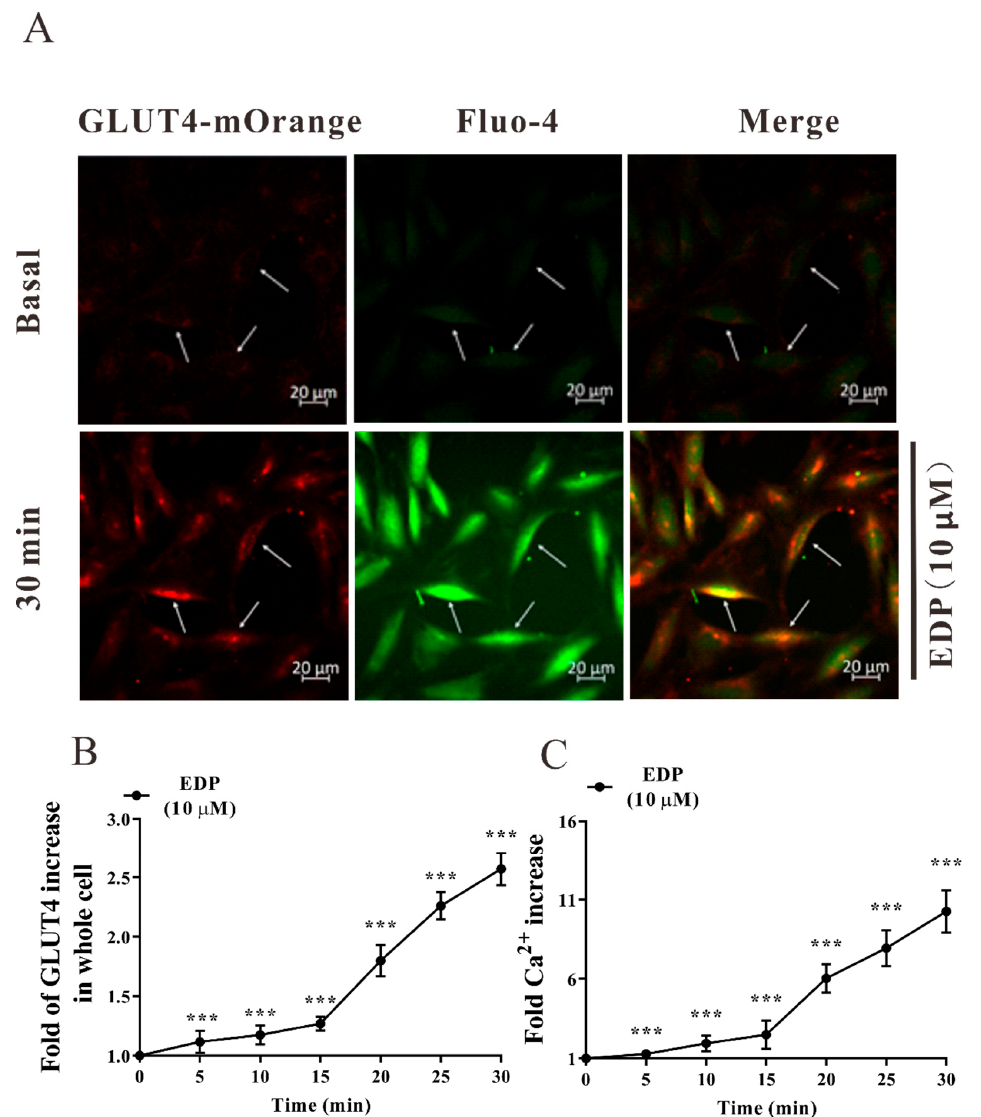
Figure 5. Estradiol Dipropionate (EDP) stimulated GLUT4 expression and intracellular Ca 2+ level. ( A ) GLUT4, intracellular Ca 2+ levels and overlays were specifically localized by GLUT4-mOrange, Flou4-AM indicator, and fluorescence Merge, respectively. Scale bar = 20 µ m. ( B ) EDP-induced GLUT4 expression occurred in a time-dependent manner for 30 min, n = 30 cells. ( C ) The Ca 2+ fluorescence intensity of L6 cells was calculated by ZEN 2010 software, n = 30 cells. *** p <